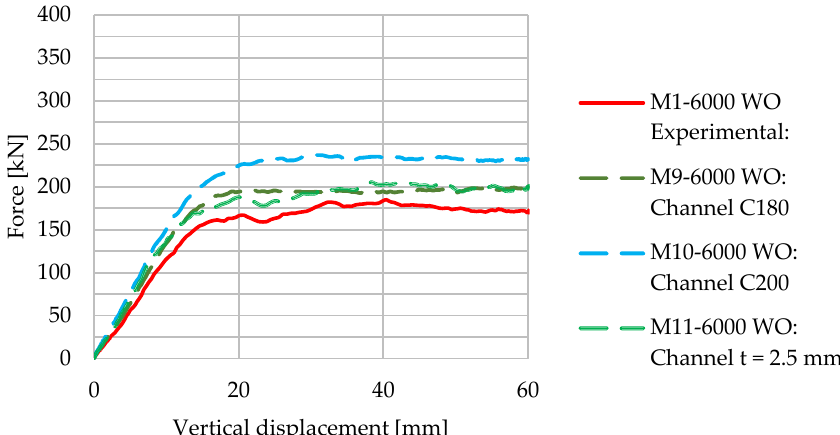
Figure 24. Force–displacement curves for the beam with a web opening, a length of 6000 mm, and different flange configurations.